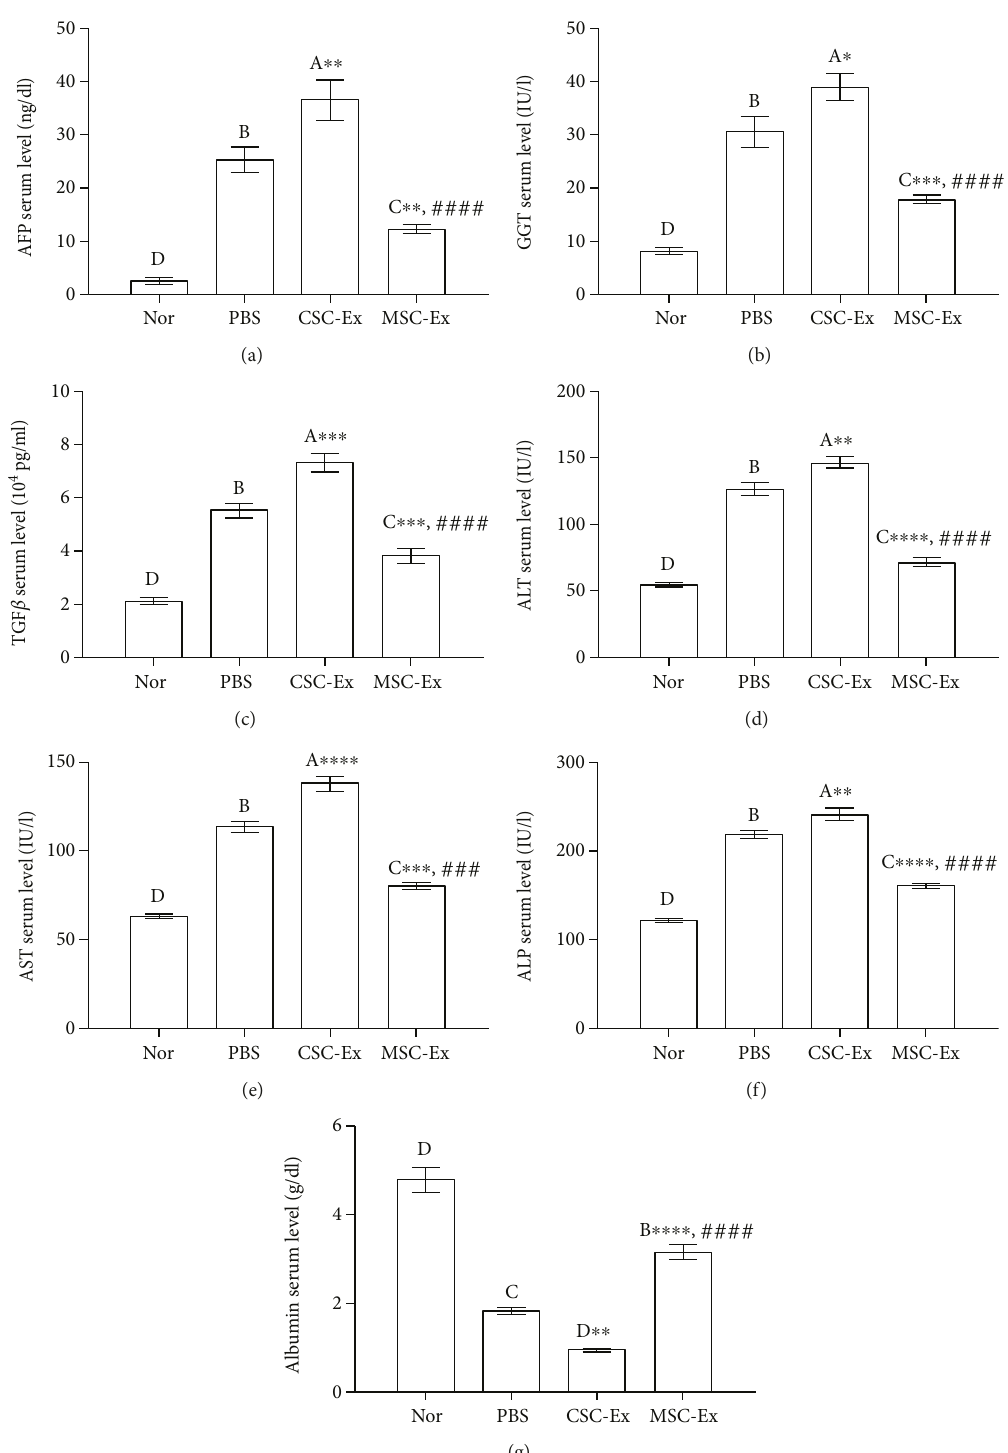
Figure 3: Serum levels of cancer markers (AFP, GGT), TGF β , liver damage enzymes (ALT, AST, and ALP), and albumin in normal rats (Nor) and DEN-induced HCC rats treated by PBS or exosomes derived from CSCs (CSC-Ex) or MSCs (MSC-Ex). Values are expressed as mean ± SEM ( n = 9/group ). Di ff erent letters on columns mean signi fi cant di ff erences. ∗ P < 0 05 , ∗∗ P < 0 01 , ∗∗∗ P < 0 001 , and ∗∗∗∗ P < 0 0001 versus PBS group; #### P < 0 0001 versus CSC